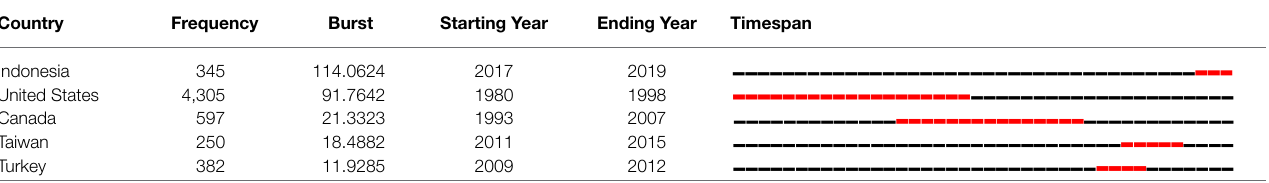
TABLE 6 | Ongoing country-level bursts in the intellectual structure of scientific literacy between the years 1980 to 2019. Country Chile